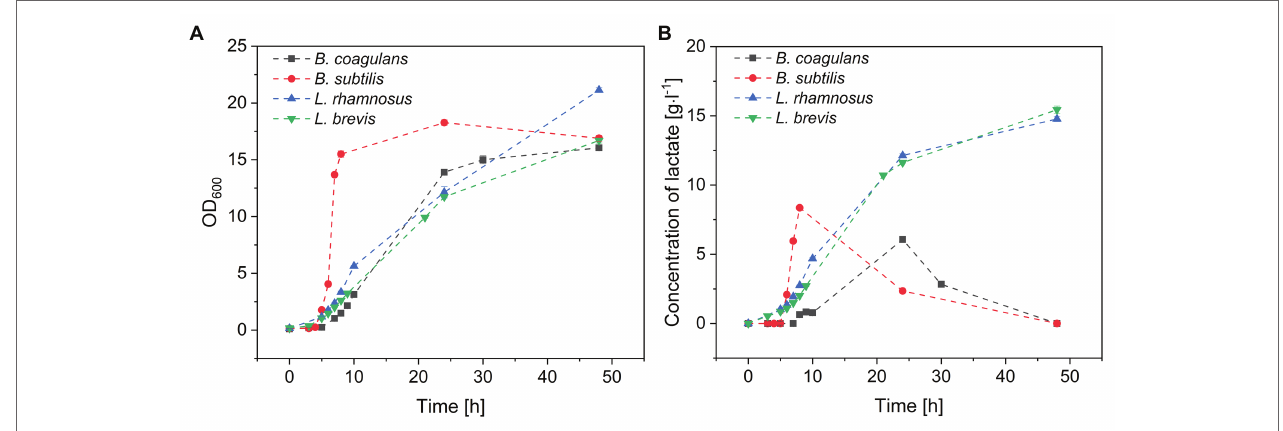
FIGURE 1 | Batch fermentation of probiotic bacteria in medium containing crude fructo-oligosaccharides (FOS). (A) Growth curve and (B) lactate concentration during the fermentation. T = 40 ° C, pH = 6.8, and agitation = 0.5 vvm. Values are means ± error ( n =